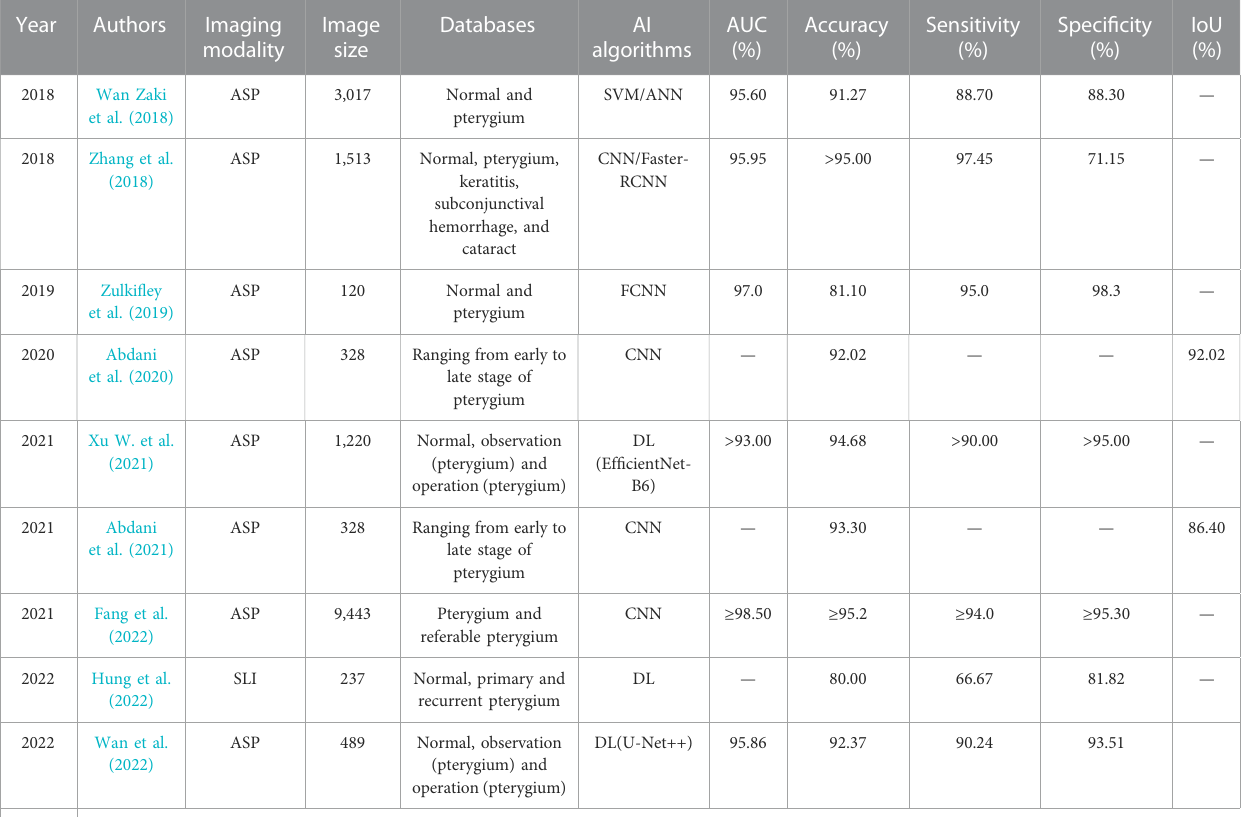
TABLE 1 Summary of studies focused on computer-aided pterygium